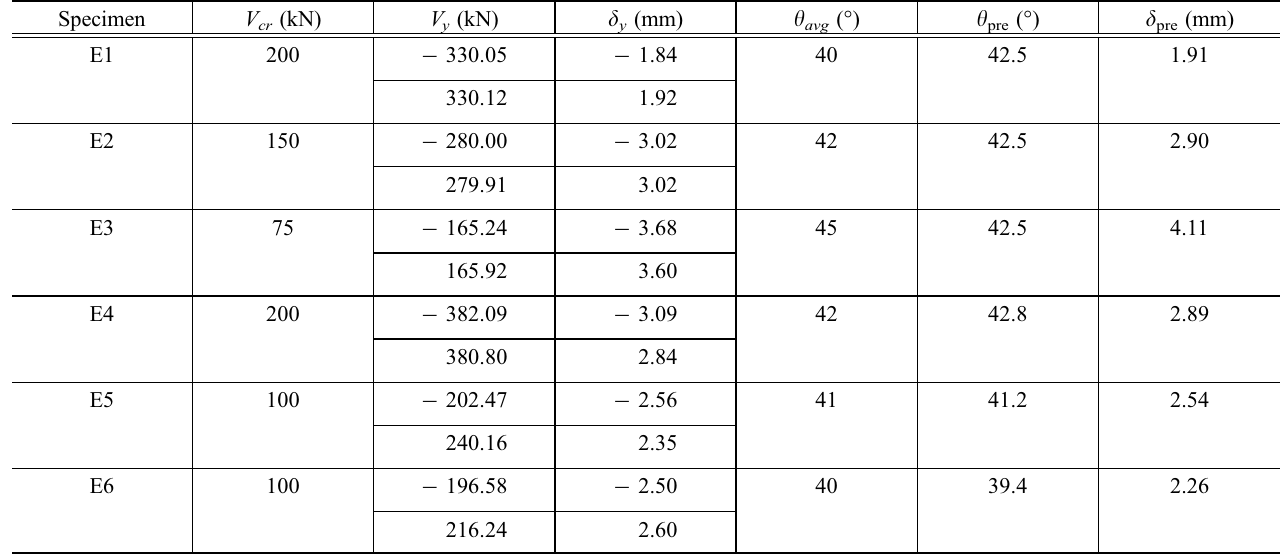
Table 6 Summary of experimental and predicted